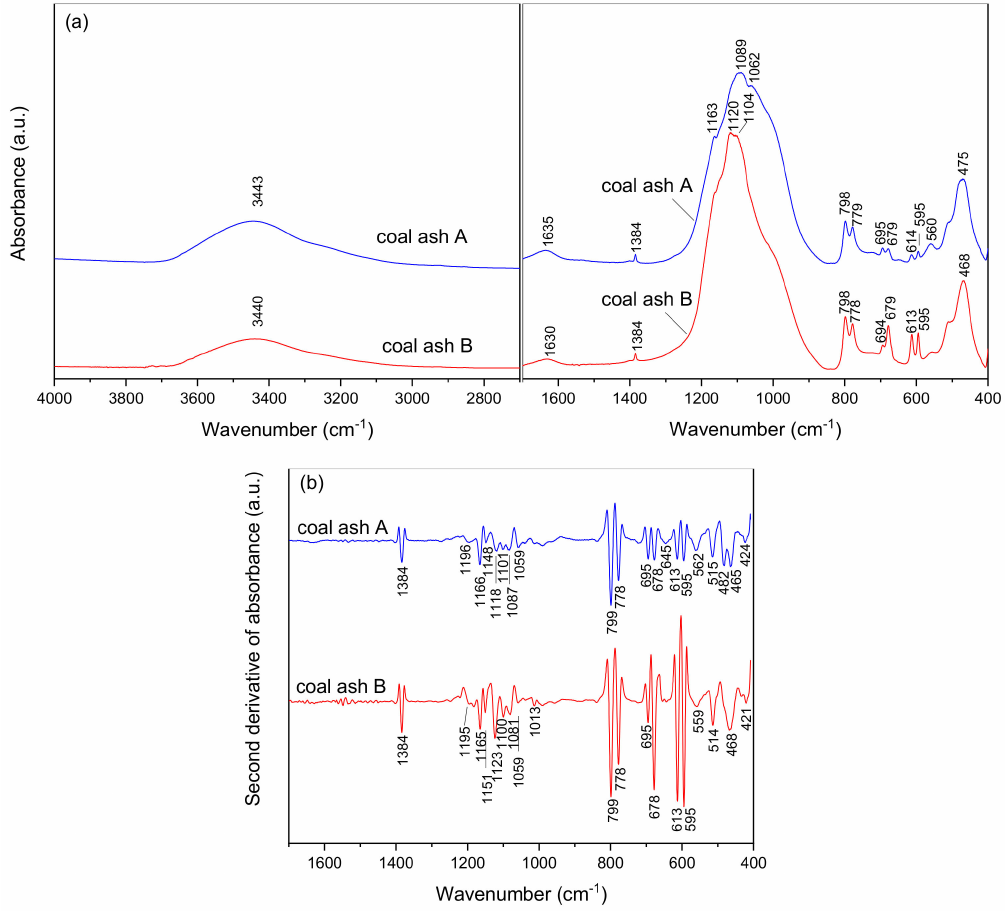
Figure 2. FTIR spectra of coal ashes: ( a ) Original spectra and ( b ) second-derivative